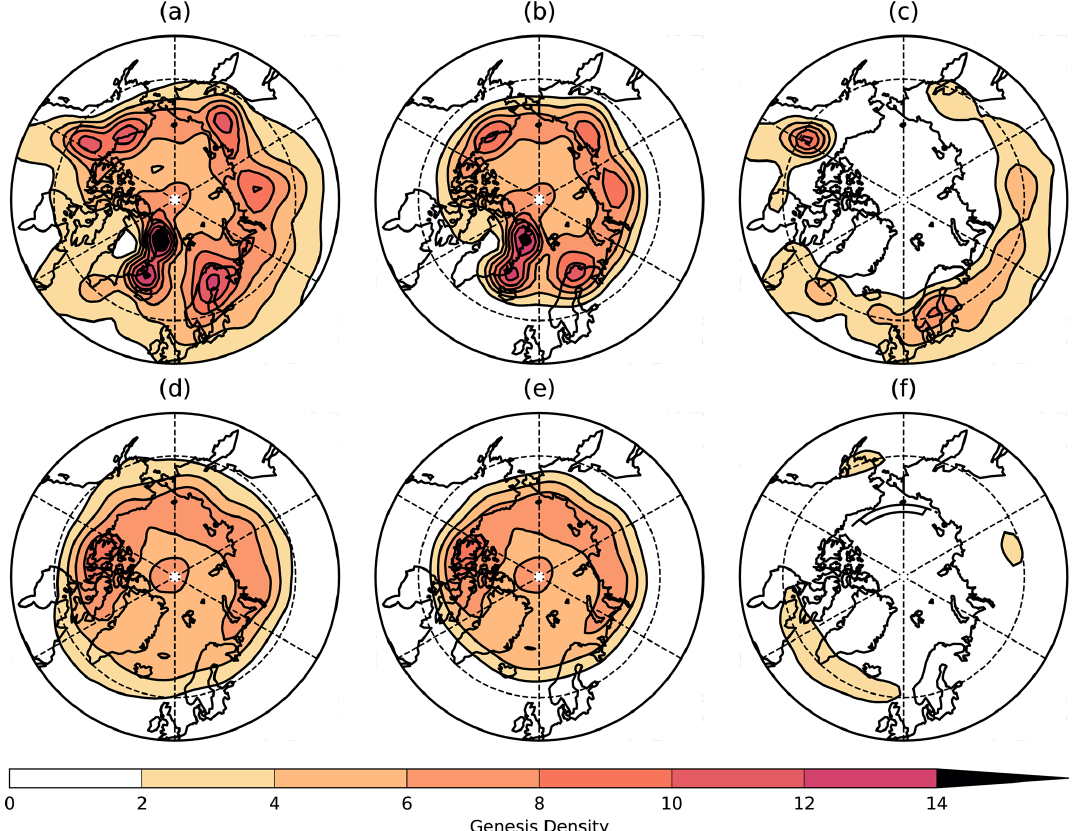
Figure 2. Genesis density of Arctic cyclones for (a) all cases, (b) Arctic genesis only and (c) non-Arctic genesis. Genesis density of TPVs for (d) all cases, (e) Arctic genesis only and (f) non-Arctic genesis. Data span the extended-summer season between 1979 and 2018. Units are number per unit area per season where the unit area is equivalent to a 5 ◦ spherical cap ( ∼ 10 6 km 2 ). The total number of tracks is (a) 12155, (b) 6822, (c) 5333, (d) 8339, (e) 6288, and (f) 2051. Maps are orientated with 0 ◦ longitude at the